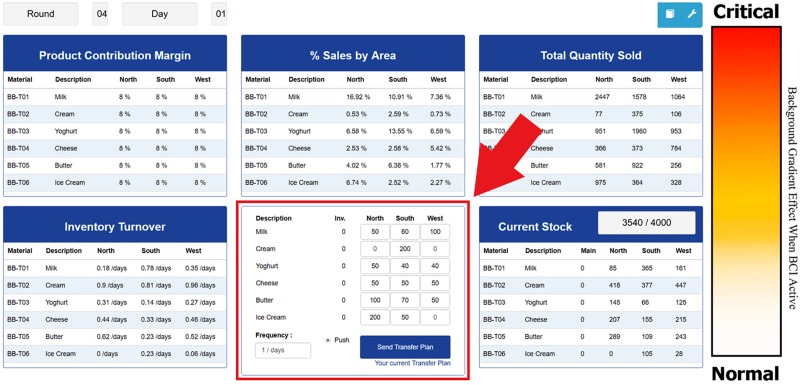
The decision-monitoring business task interface with task interface countermeasure, (Left) arrow denotes interactive decision console; (Right) the color gradient feedback schema, red to amber = very low to low sustained attention, white = moderate to high level of sustained attention; interface background changes color in accordance with level of sustained attention.